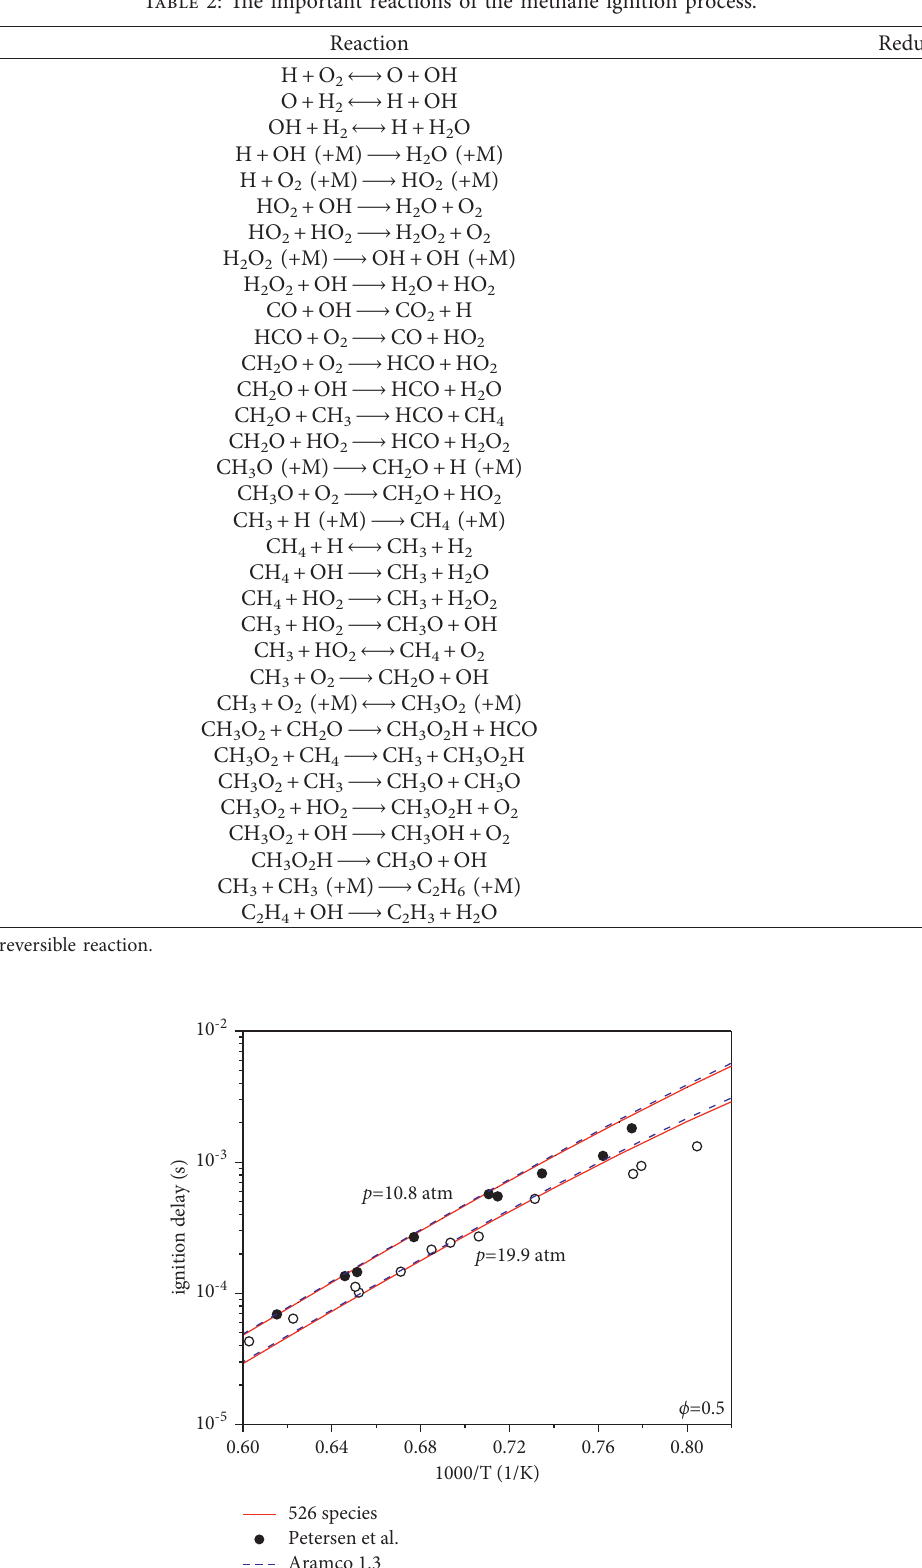
Table 2: The important reactions of the methane ignition process.